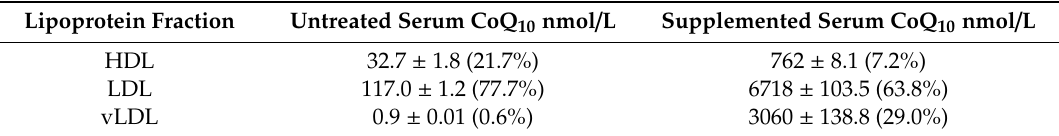
Table 3. Distribution of CoQ 10 in the major lipoprotein